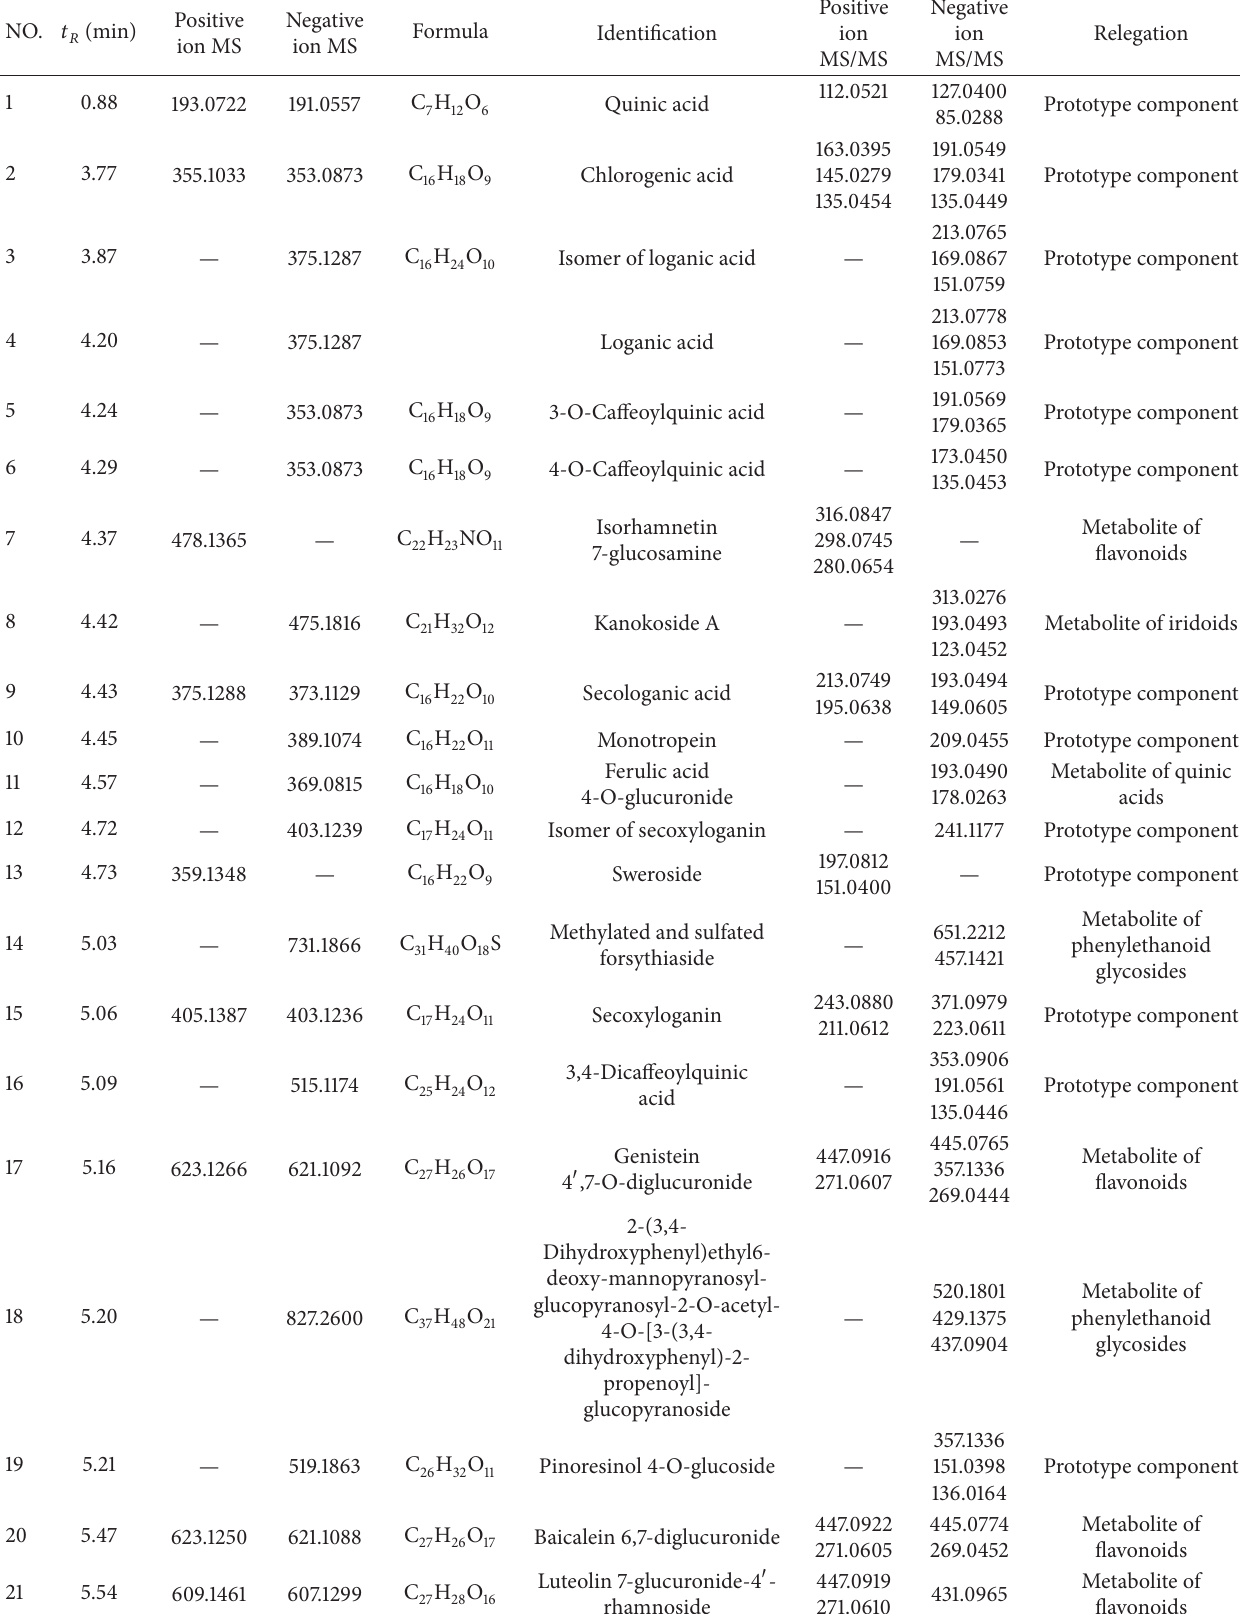
Table 2: The prototype components and metabolites in human serum after SHLI dosed in both positive and negative mode. NO. 𝑡 𝑅